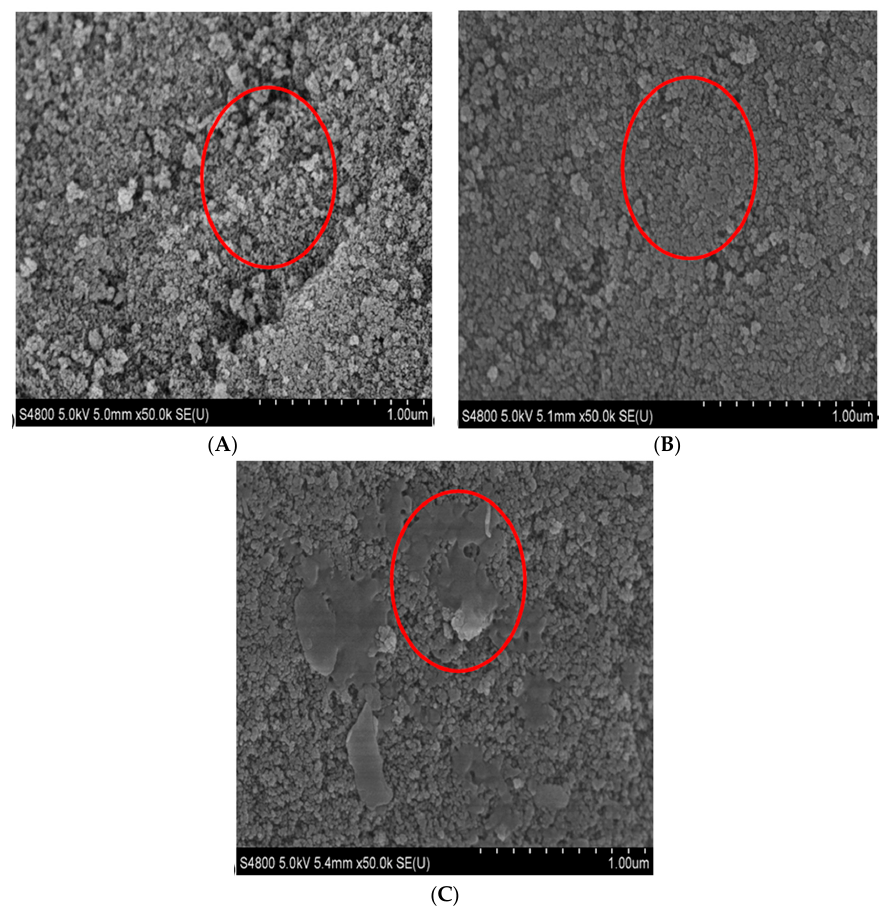
Figure3. FESEM images of ( A ) the activated silica gel; ( B ) APS-Si; and ( C ) APS-Si-GA-COX-2. Figure 3. FESEM images of ( A ) the activated silica gel; ( B ) APS-Si; and ( C )